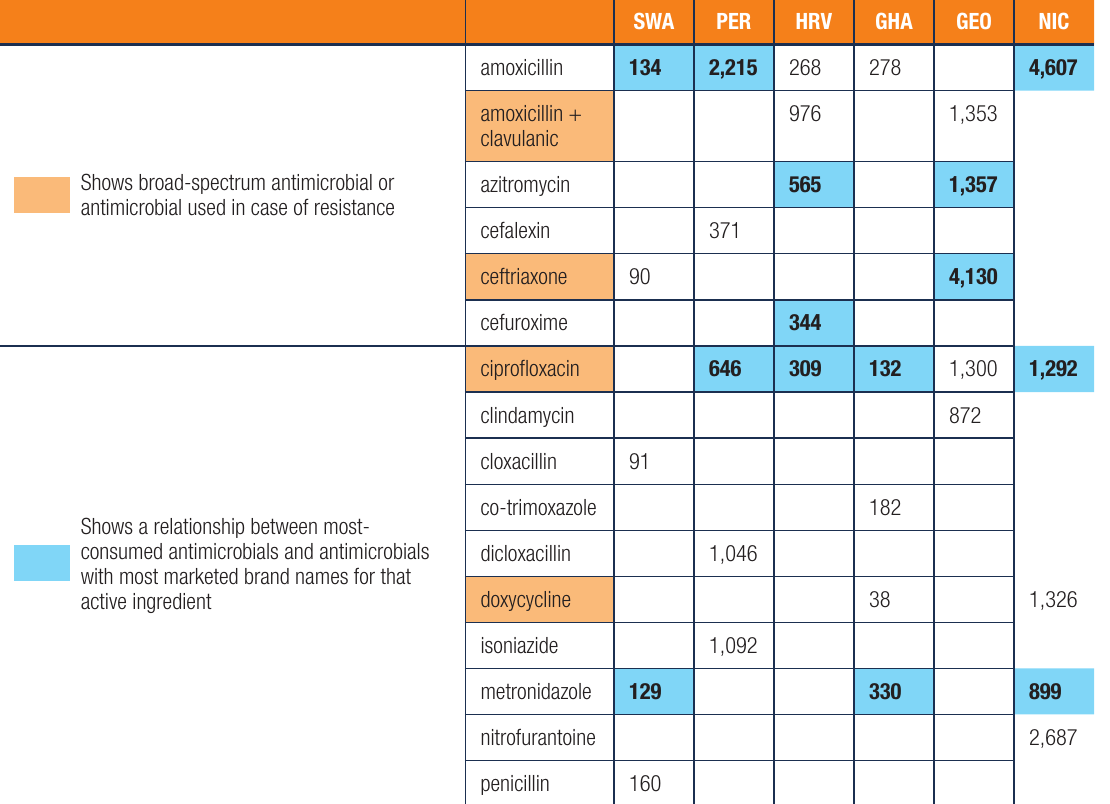
Shows broad-spectrum antimicrobial or antimicrobial used in case of